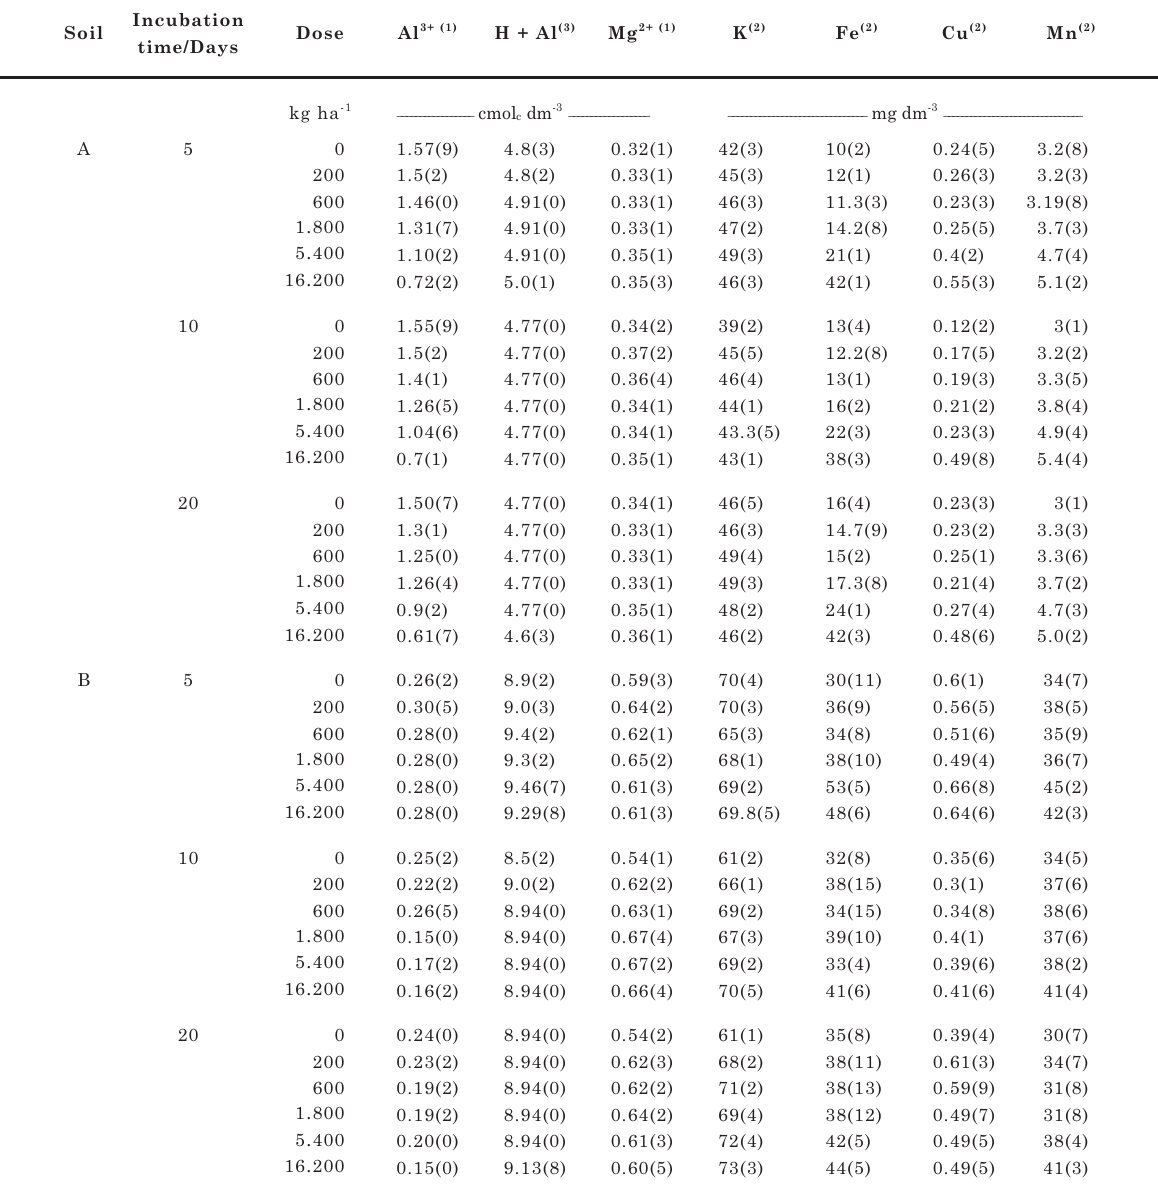
Table 2. Nutrients and toxic elements in the soil extracts after application of increasing doses of residue in different incubation